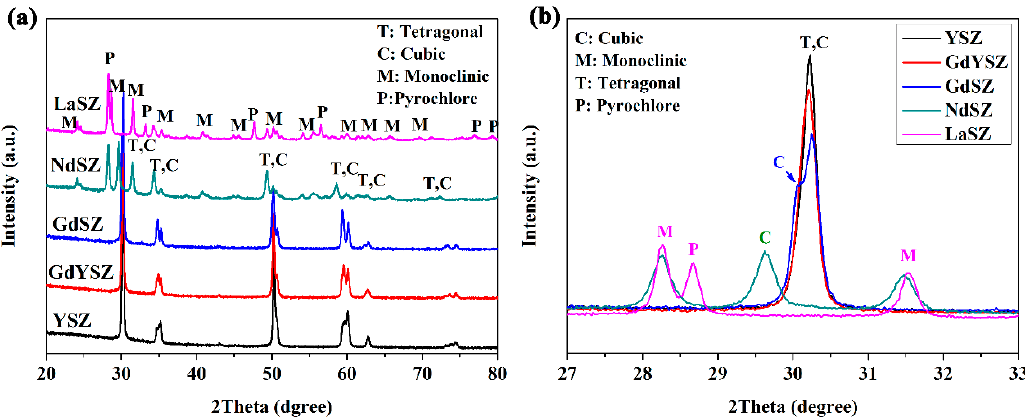
Figure 5. XRD patterns of LnSZ powders after 90 h of heat treatment at 1300 ℃ : ( a ) the full XRD patterns and ( b ) XRD patterns within a 2 θ range of 27–33°.